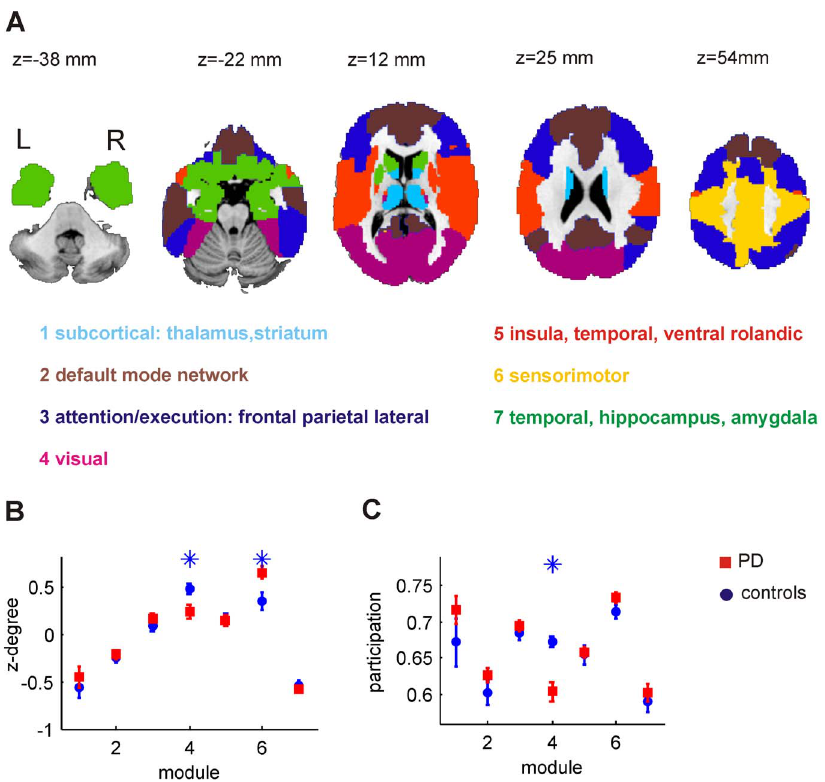
Figure 4. Modular structure of the brain network. A) Overview of the different network modules. B) mean z-degree of nodes comprising module C) mean participation nodes comprising module for patients (red squares) and controls (blue circles).